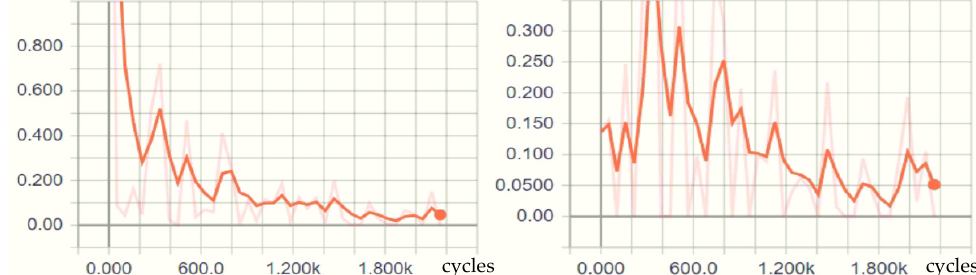
cycles Appl. Sci. 2021 , 11 , x FOR PEER REVIEW 11 of 16 Figure 13. Training graphs for classification ( left ) and localization ( right ). Table 1. The acquired results by autogenerated training samples based on virtual 3D models.